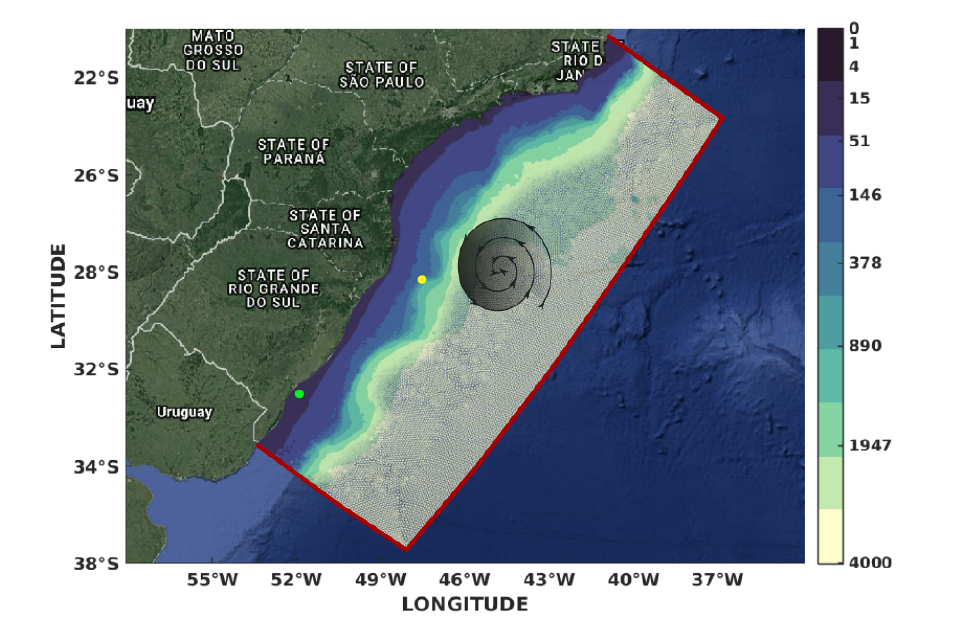
Figure 1. Study area located in the South-Southeastern Brazilian Shelf. The red lines represent the oceanic liquid boundaries and the spiral represents the atmospheric surface conditions. The green dot represents the initial position of the ship. The yellow dot represents the in situ data from buoy PNBOIA-SC. Bathymetry is shown in the color